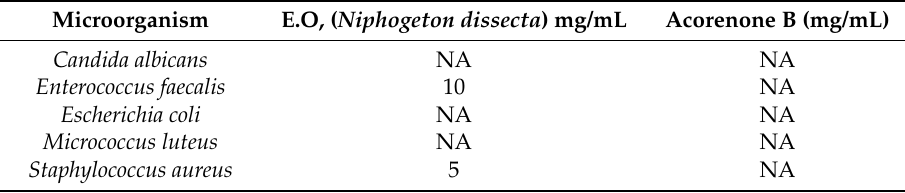
Table 3. Strains used for biological tests.